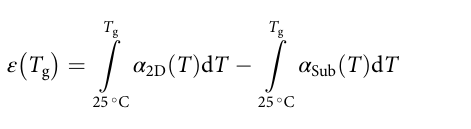
Supplementary Fig. 2. By comparing the lattice constant extracted from the diffraction patterns of strained (as-grown) and